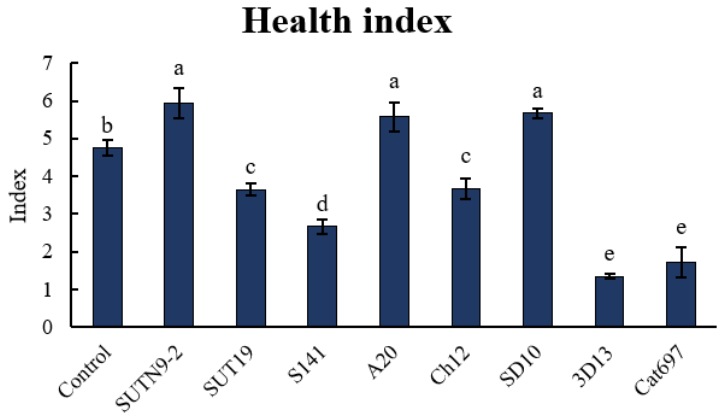
Figure 5. The effect of PGPR on tomato seedling growth. The tomato seedlings were recorded at 14 days after planting. Mean and standard error are calculated from four replicates. Values with dif- ferent letters in each treatment differed significantly at p ≥ 0.0 5 .